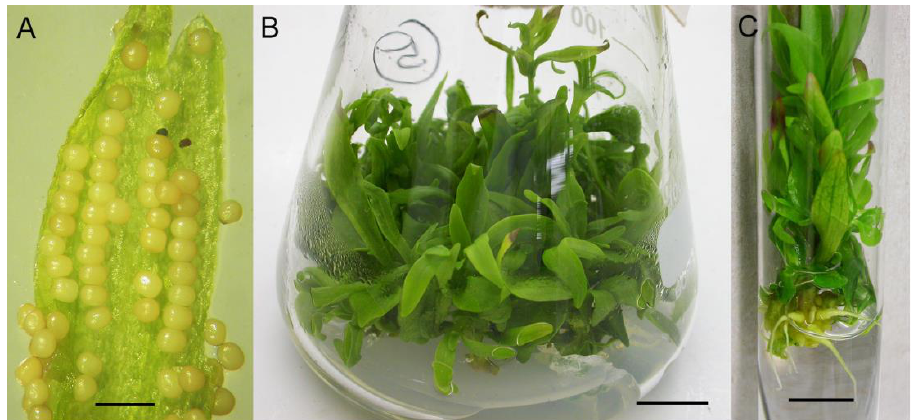
Figure 4. In vitro propagation of G. lutescens . ( A ) Open pod with immature seeds ( bar = 5 mm), ( B ) shoot multiplication on BM + 0.2 mg L −1 BA ( bar = 10 mm), ( C ) root elongation in PGR-free ½ MS liquid medium after treatment of shoots with 5.0 mg L −1 IBA for 2 days ( bar = 10 mm). Table 1. Shoot induction and multiplication and the length of the main shoot in G. lutescens . Epicotyl explants of five seedling lines were cultivated on BM + 0.2 mg L −1 BA for 35 days. Values represent the means ± SE from two experiments with 35–40 samples per line ( n = 75–80). Data were analyzed by one-way ANOVA analysis. Within each column means followed by different letters are significantly different according to Fisher’s LSD test at p ≤ 0.05. Multiplication index: main shoot + axillary buds.